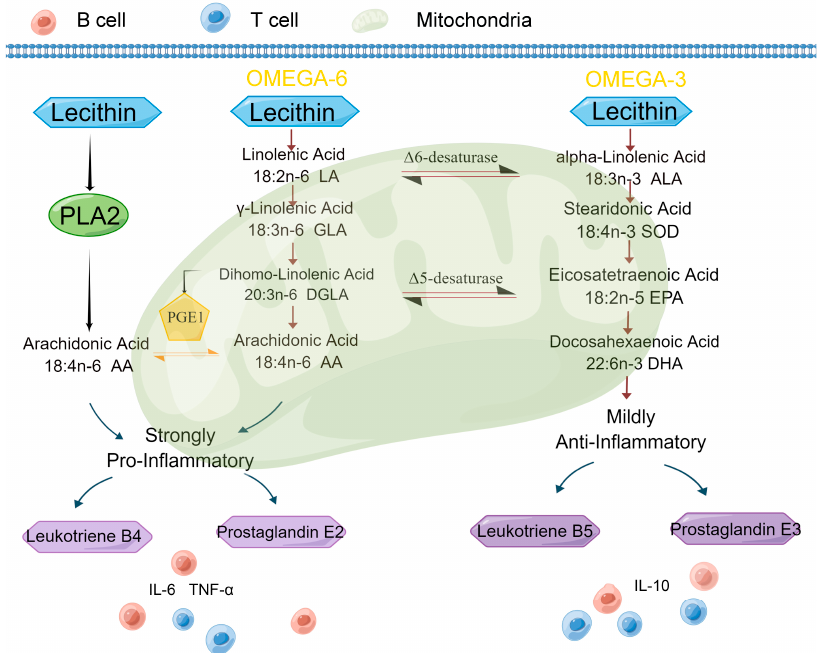
Figure 11. Phosphatidylcholine as a precursor in unsaturated fatty acid metabolism induces immune cell activation to participate in immunity tolerance.